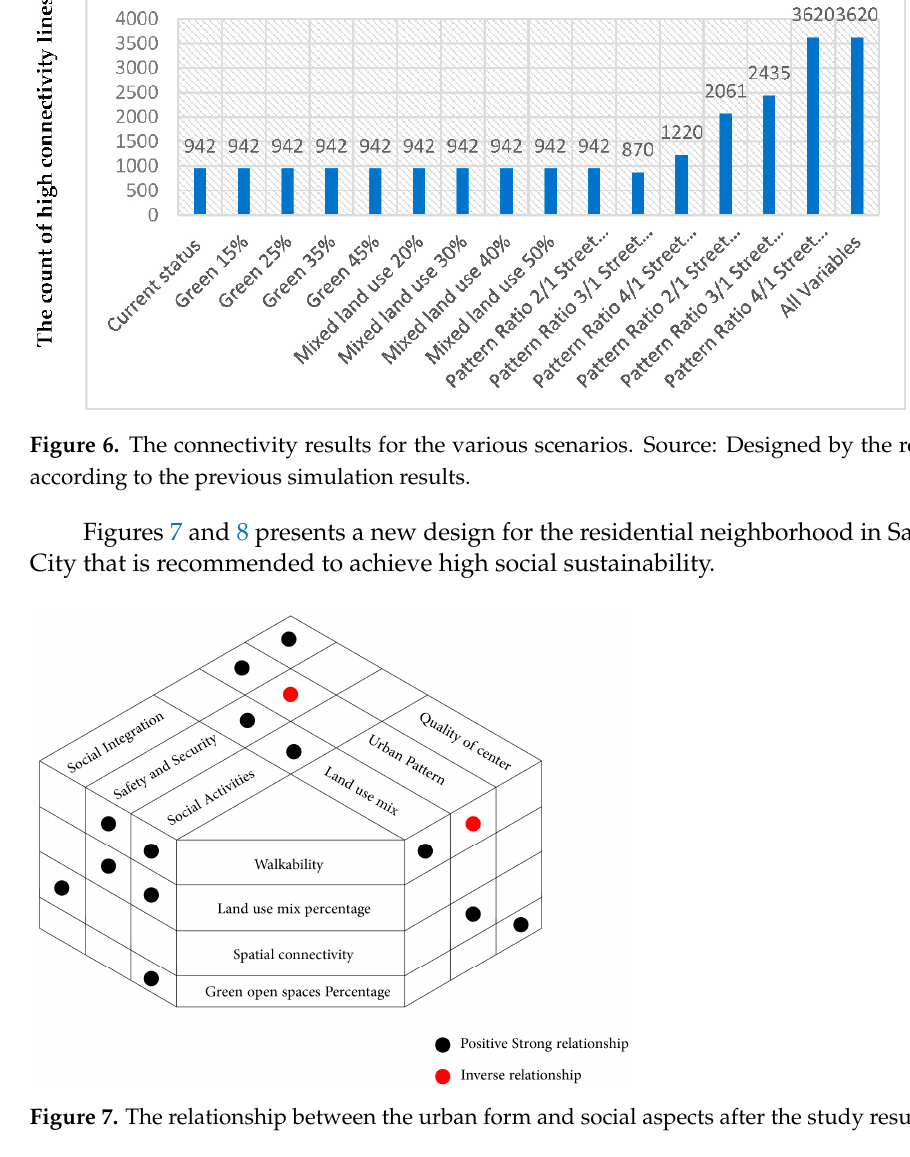
Figure 6. The connectivity results for the various scenarios. Source: Designed by the researchers according to the previous simulation results.